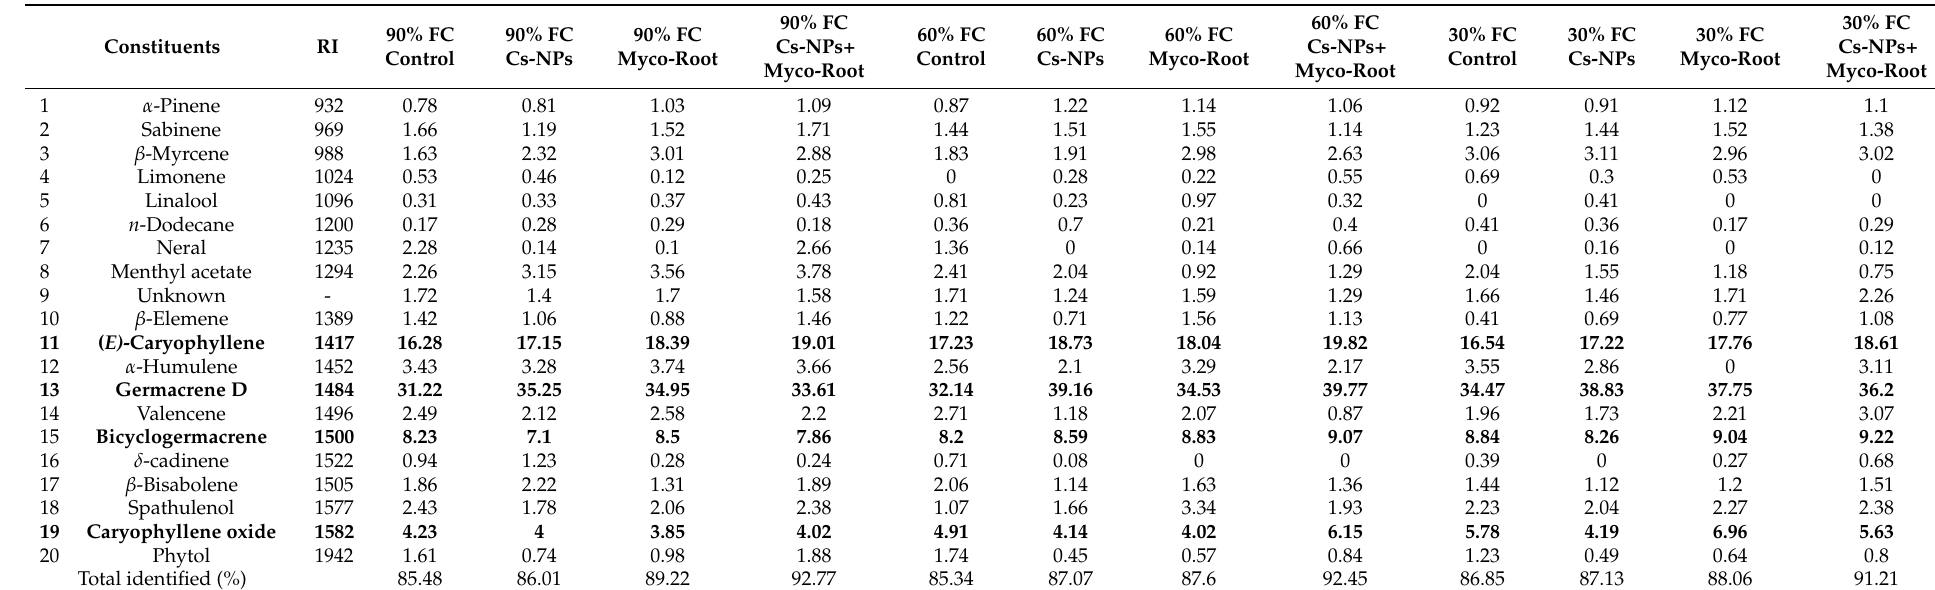
Table 2. The essential oil constituents of L. iberica affected by different levels of drought stress and fertilizer